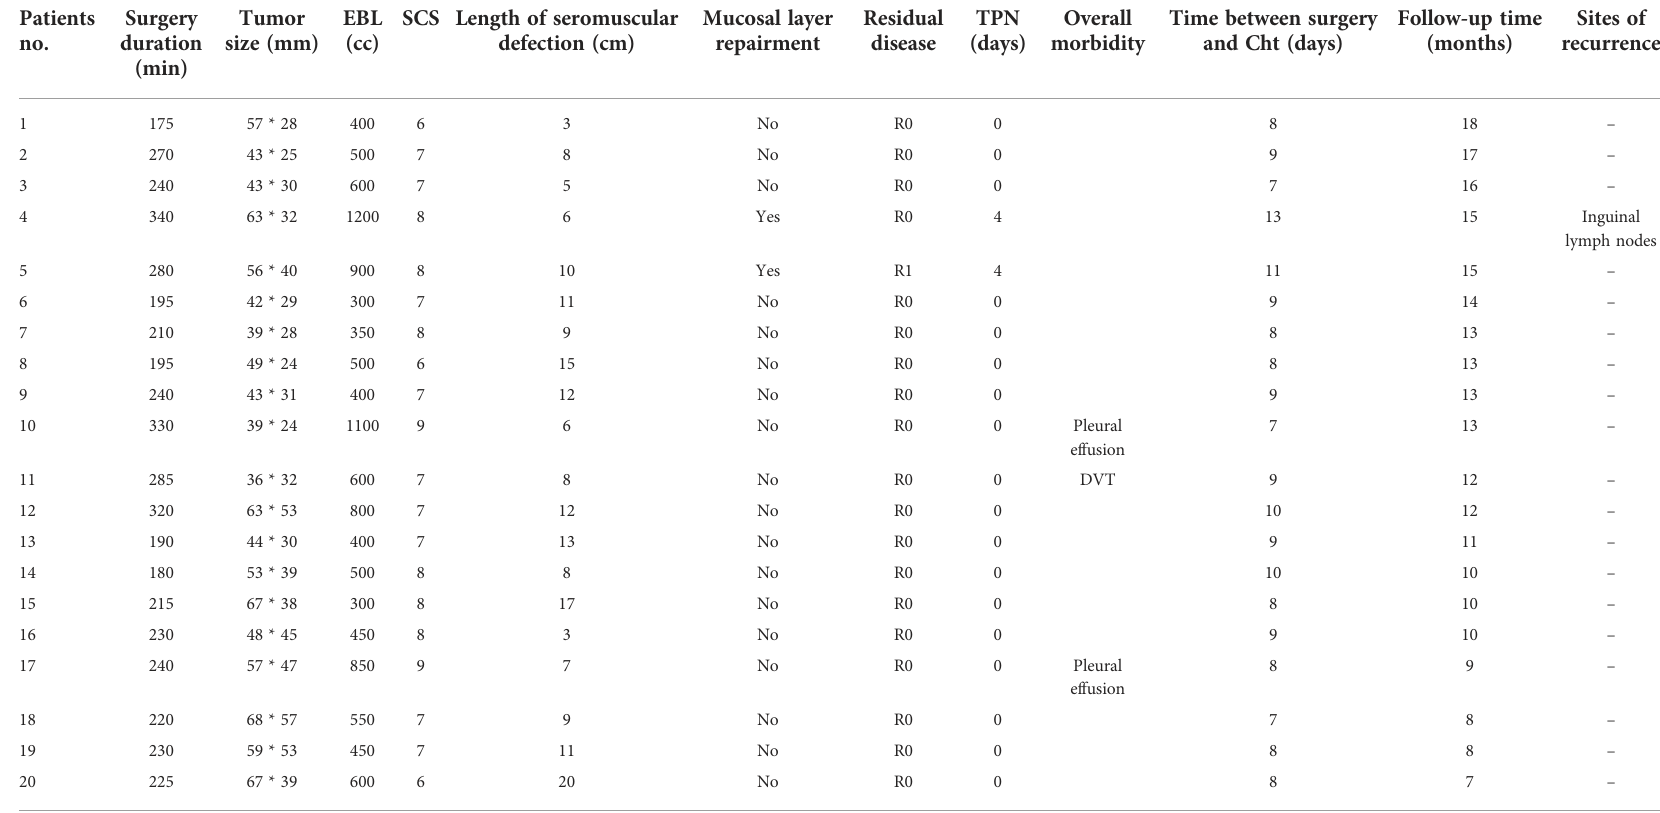
TABLE 3 Intra-operative and post-operative outcomes. Patients